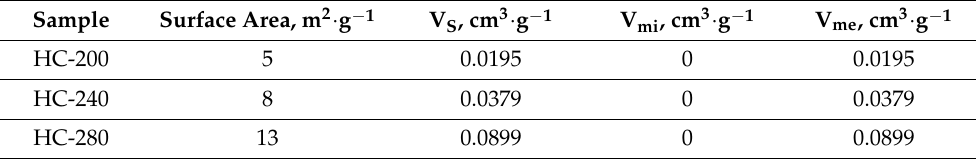
Figure 7. Adsorption-desorption isotherms of nitrogen for ( a ) HC-200; ( b ) HC-240; ( c ) HC-280. Table 6. Specific surface area and porosity of hydrochars.